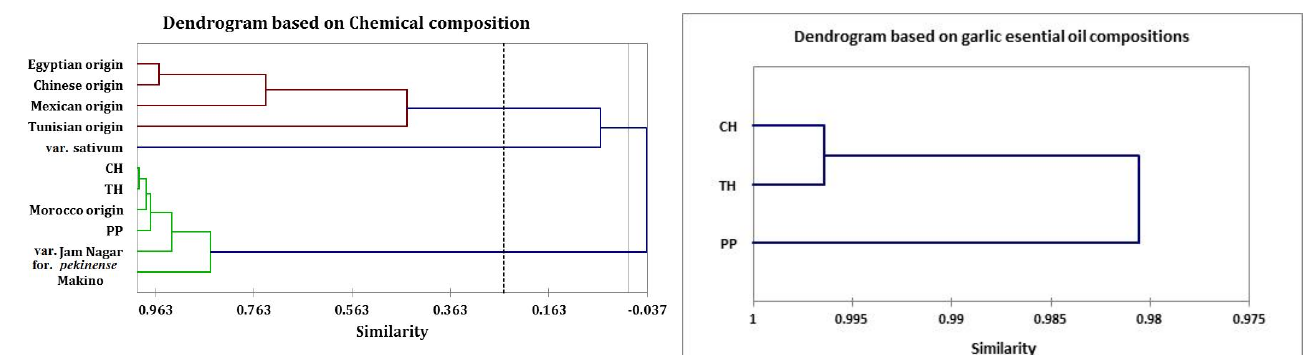
Fig. 3: The dendrogram of the chemical composition of garlic oil obtained from A. sativum L. cv.Thai (TH), cv. Chinese (CH) and cv. Ping- pong (PP), of Morocco origin (D OUIRI et al., 2014), var. Jam Nagar (S OWBHAGYA et al . , 2009), for. pekinense Makino (P YUN and S HIN , 2006), var. sativum (K HARAZI , 2005), Egyptian origin, Chinese origin, Mexican origin (S HAATH and F LORES , 1995) and Tunisian origin (D ZIRI et al . , 2014) derived by UPGMA from the similarity matrix of 75 chemical compositions.